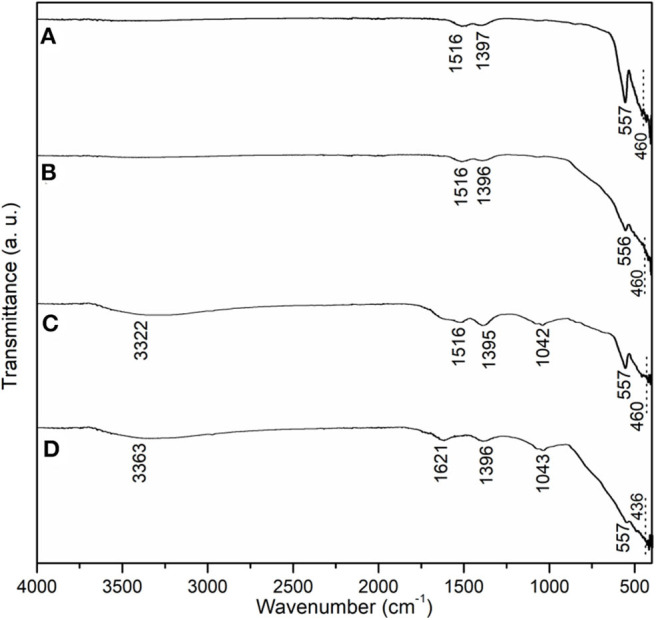
FT-IR spectrum of C3: (A) fresh, (B) after 1st use, (C) after 2nd use, (D) after 3rd use.